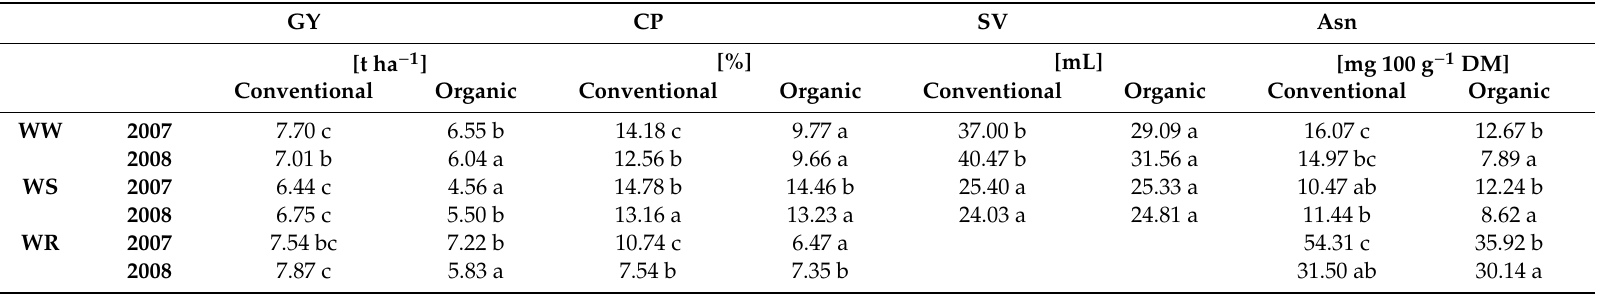
Table 6. Grain Yield (GY), quality parameters (crude protein [CP], sedimentation value [SV]) and free Asn) of the three tested species depending on management system and year. Treatments within the same species (WW = winter wheat, WS = winter spelt, WR = winter rye) assigned by the same letters are not significantly di ff erent ( α = 0.05, t